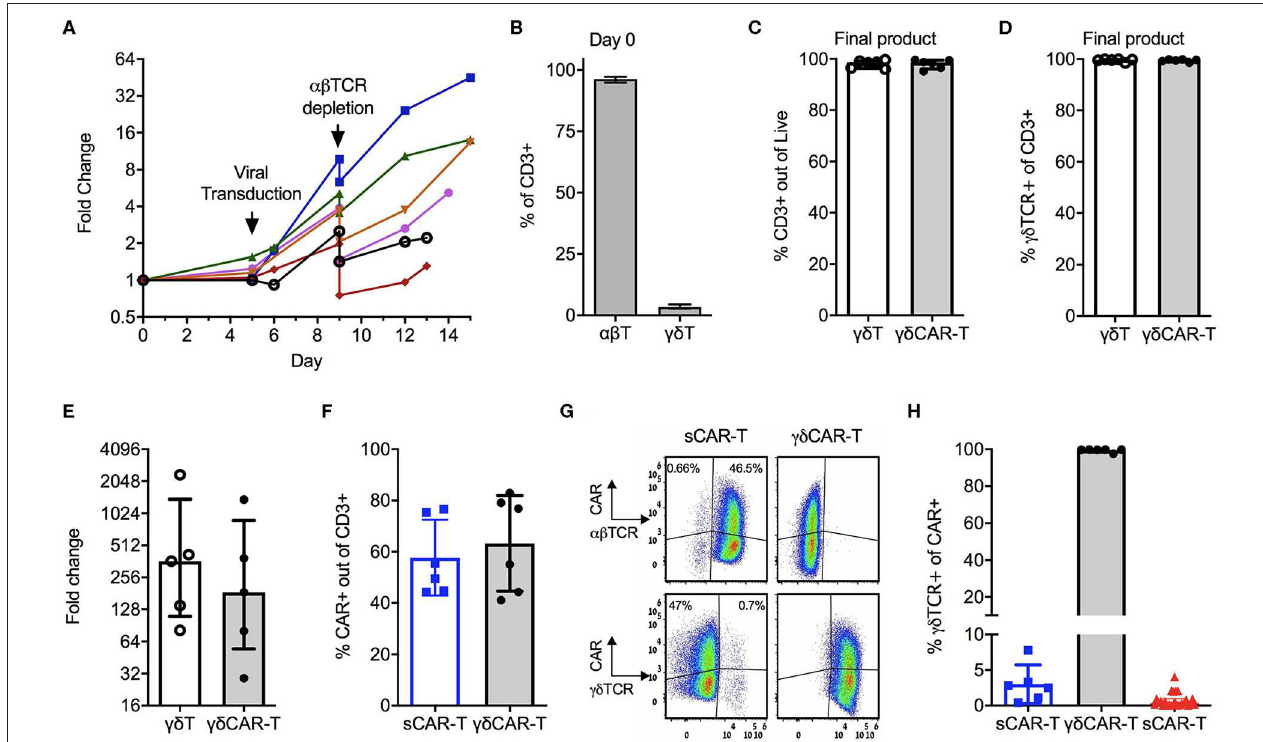
FIGURE 1 | Production of γδ CAR-T cells: (A) Production scheme, showing total cell expansion (by fold change) along the protocol. Day 0 is the collection of blood, PBMCs isolation, and T cell activation. Each line represents a different healthy donor. (B) γδ -T/ αβ -T cells composition of donors’ blood out of CD3 positive cells ( n = 5). (C) CD3 positive cells in the final product of un-transduced γδ -T and transduced γδ CAR-T cells ( n = 6). (D) Purity of γδ TCR + cells in the final product of both protocols ( n = 6). (E) γδ -T cells fold change expansion during the γδ CAR-T production protocol ( n = 5). (F) CAR transduction efficiency by flow cytometry gated on CD3 positive cells, of the standard CAR (sCAR) and γδ CAR-T cell products ( n = 6). (G) Dot plots of a representative sample showing CAR expression in γδ and αβ -T cells populations in the final product of sCAR and γδ CAR-T cell protocols. (H) γδ TCR positive cells gated on CAR positive cells in the final composition of sCAR-T cells (blue squares, n = 6), γδ CAR-T cells production protocol (black circles, n = 6) and the clinically manufactured sCAR-T cells (red triangles, n = 25). Bars are at the median value, and error bars represent interquartile